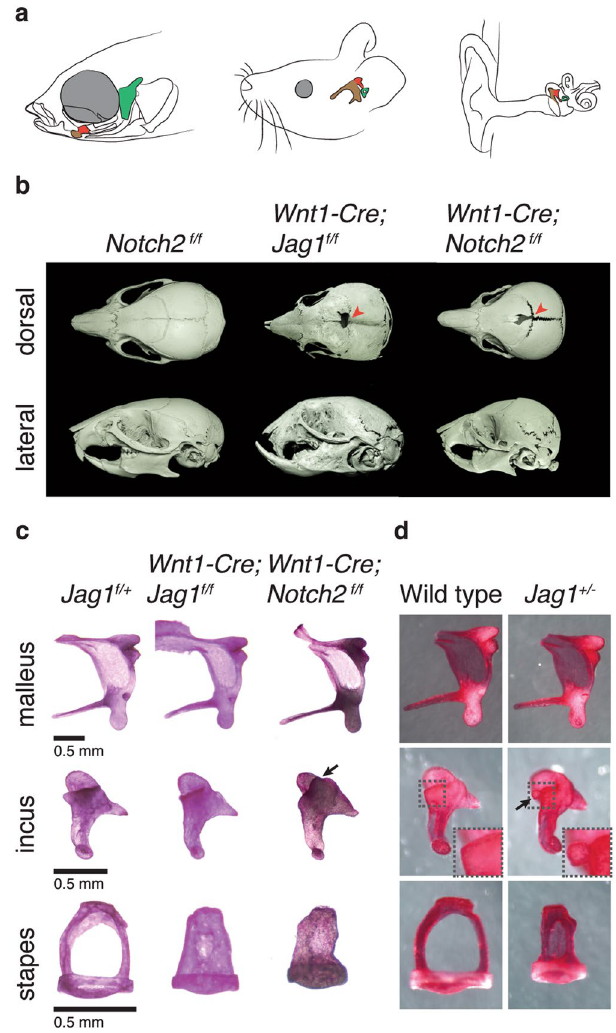
Figure 1. Craniofacial and middle ear defects in mice deficient for Jag1 or Notch2 . ( a ) Diagrams of the heads of zebrafish, mouse, and human (left to right) show homology between the fish jaw skeleton and the mammalian middle ear ossicles. The fish hyomandibula is homologous to the mammalian stapes (green); the fish palatoquadrate is homologous in part to the mammalian incus (red); and the proximal portion of the fish Meckel’s cartilage is homologous to the mammalian malleus (brown). ( b ) Micro-CT scans of mouse skulls at three weeks of age. Compared to control Notch2 f/f mice, Wnt1-Cre ; Jag1 f/f and Wnt1-Cre ; Notch2 f/f mice exhibit a persistent foramen (arrowheads in dorsal view) and midfacial hyperplasia resulting in an abnormally shaped skull and malocclusion (lateral view). ( c , d ) Dissected middle ear ossicles of three-week-old mice stained with Alizarin Red S. Compared to Jag1 f/ + controls, Wnt1-Cre ; Jag1 f/f and Wnt1-Cre ; Notch2 f/f mice display a fully penetrant columellar stapes phenotype. Wnt1-Cre ; Notch2 f/f mice also rarely display an ectopic process from the anterior medial edge of the incus (arrow). Compared to wild-type siblings, some Jag1 + / − mice display a columellar stapes and a small ectopic process from the posterior medial edge of the incus body (arrow and